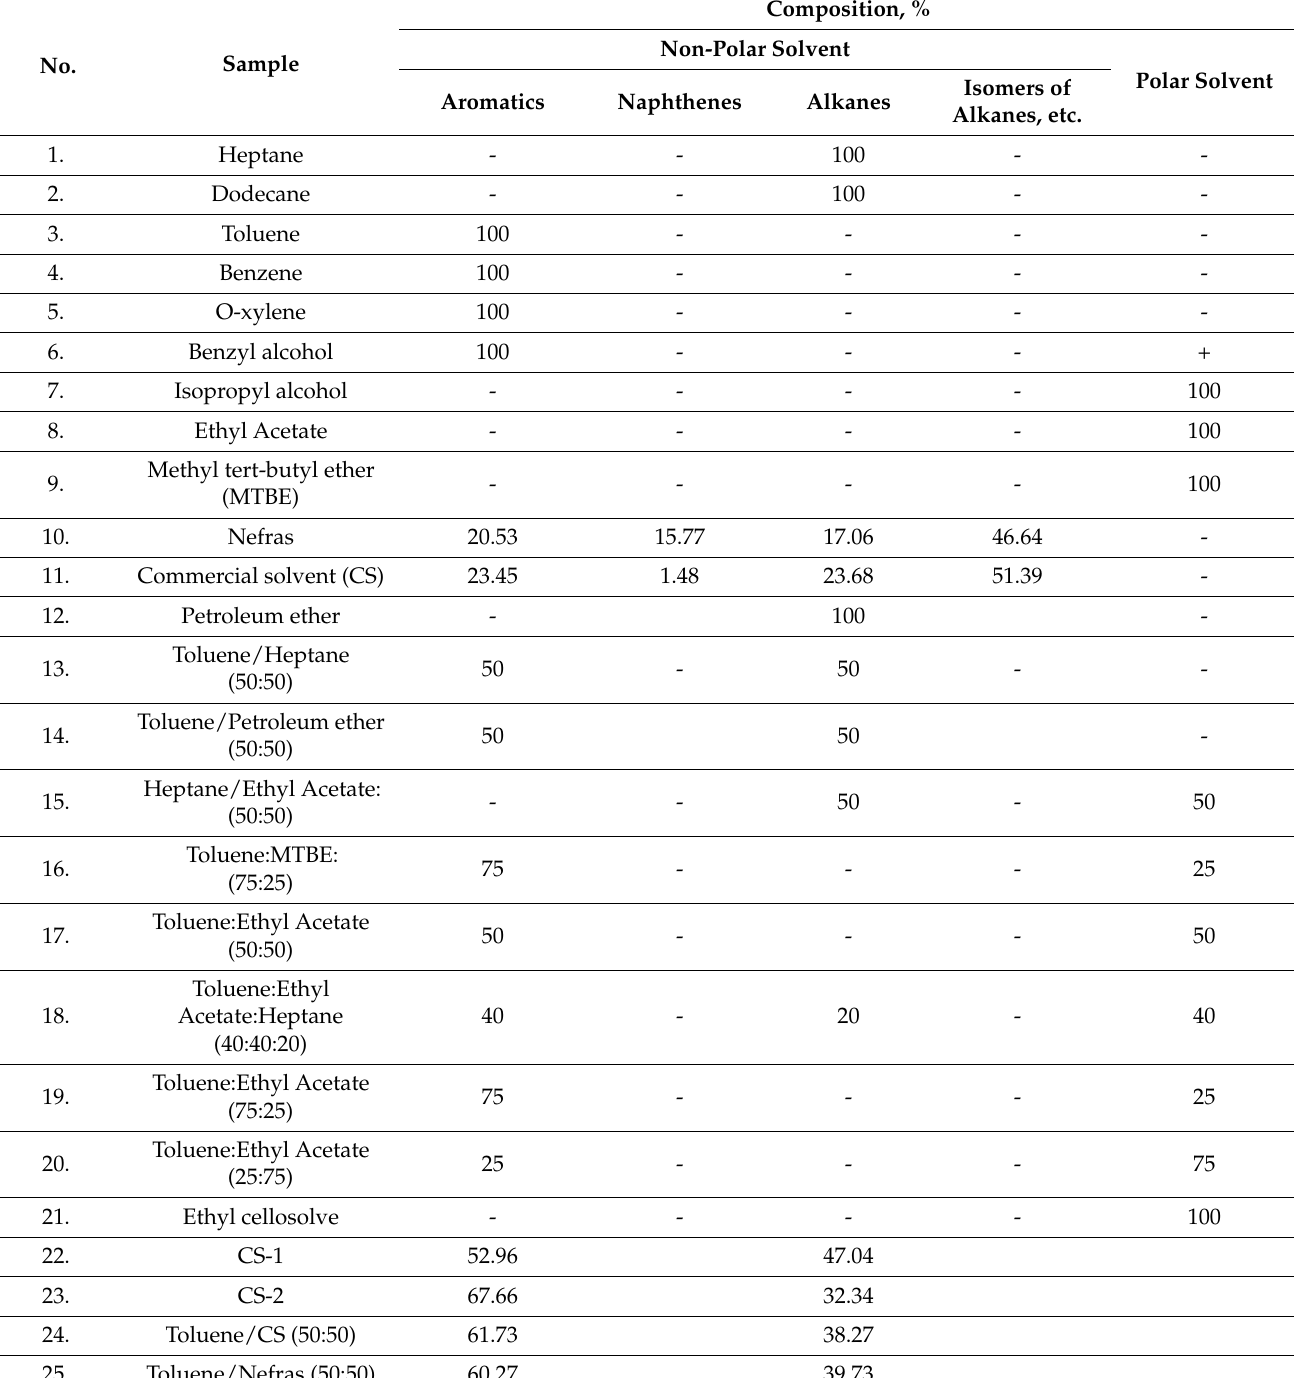
Table 2. Physical properties and chemical composition of the used